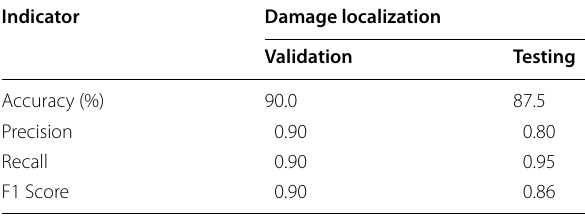
Table 3 Performance indicators calculated from the classification of CWT images of close and far damage Indicator Damage localization